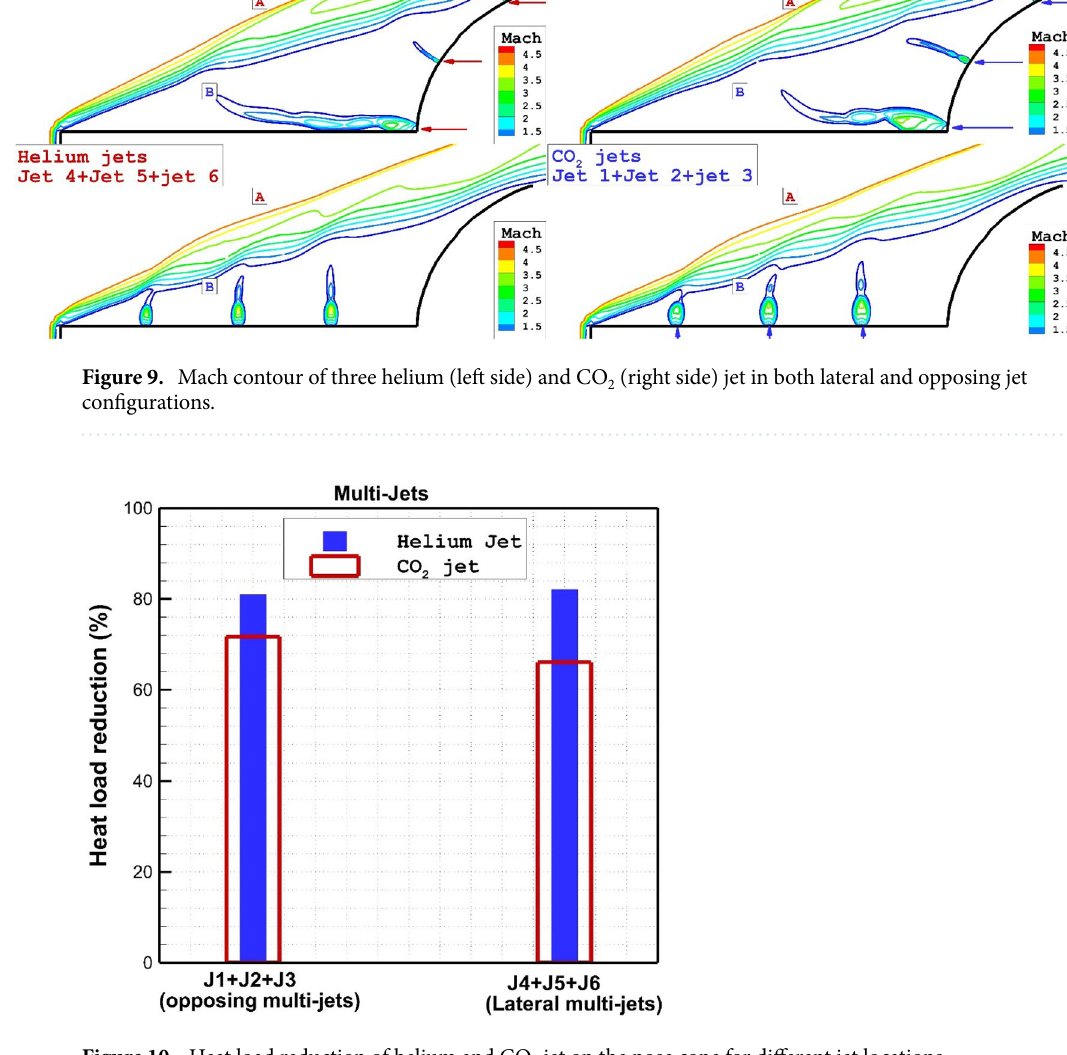
Figure 10. Heat load reduction of helium and CO 2 jet on the nose cone for different jet